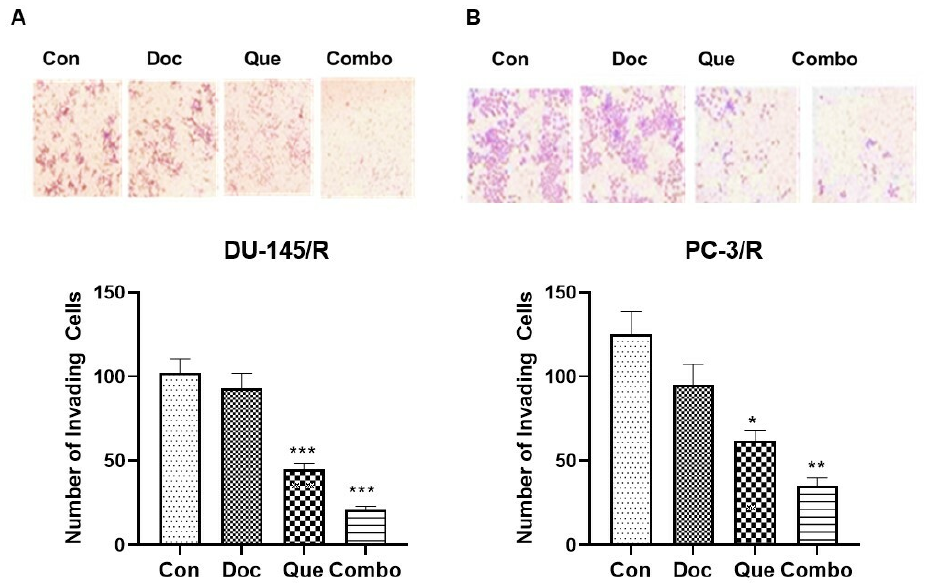
Figure 5. Invasive activity of docetaxel-resistant prostate cancer cell lines DU-145/R ( A ) and PC-3/ ( B ) in treatments with different drugs and drug combinations. Cells were applied to the upper surface of a filter coated with basement membrane proteins using a cell invasion assay, as described in Section 2. After incubation for 48 h, the upper surface of the filter was scrubbed free of cells and protein, the filter was fixed and stained, and the lower surface was photographed. The top panel shows representative photographs at a magnification of × 100: Lanes 1–4 are the control, docetaxel, quercetin, and combination treatments, respectively. The bottom panel in each figure shows quantitative values of the total number of cells invading through the filter. * p < 0.1, ** p < 0.01 *** p < 0.001.